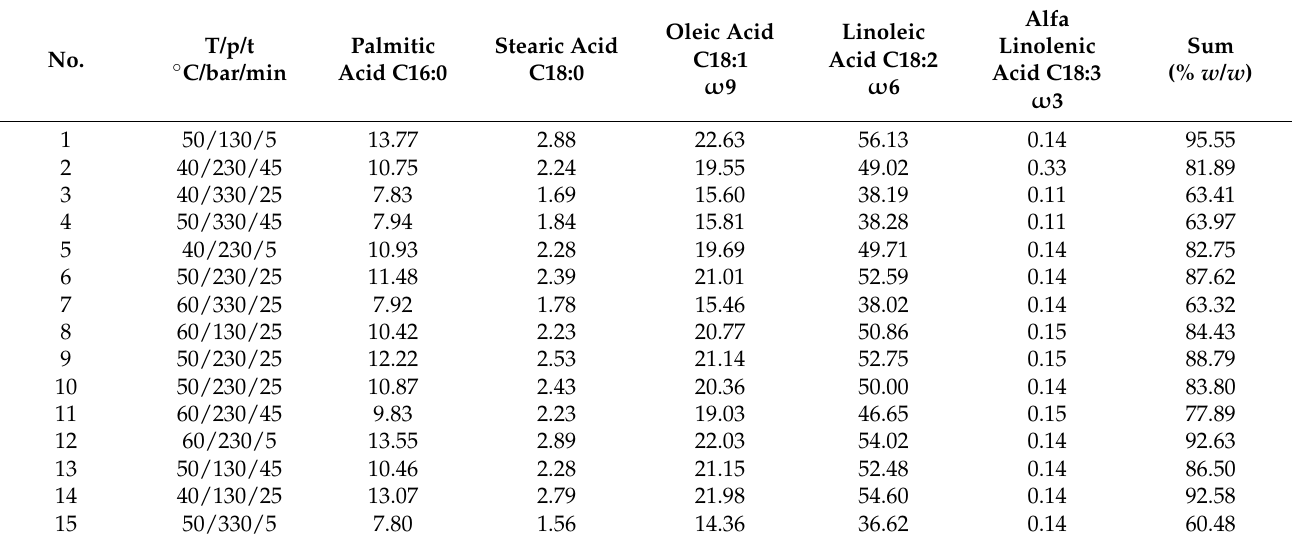
Table 8. The content of individual fatty acids in black cumin extracts (% w/w ) vs. BBD experiment